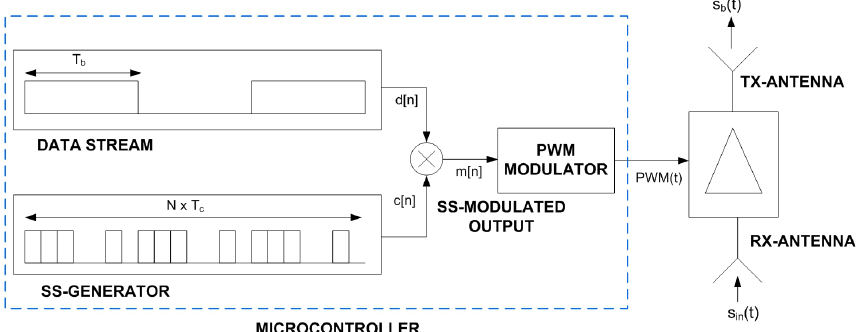
Figure 7. Multiplication of the data stream with a spread-spectrum